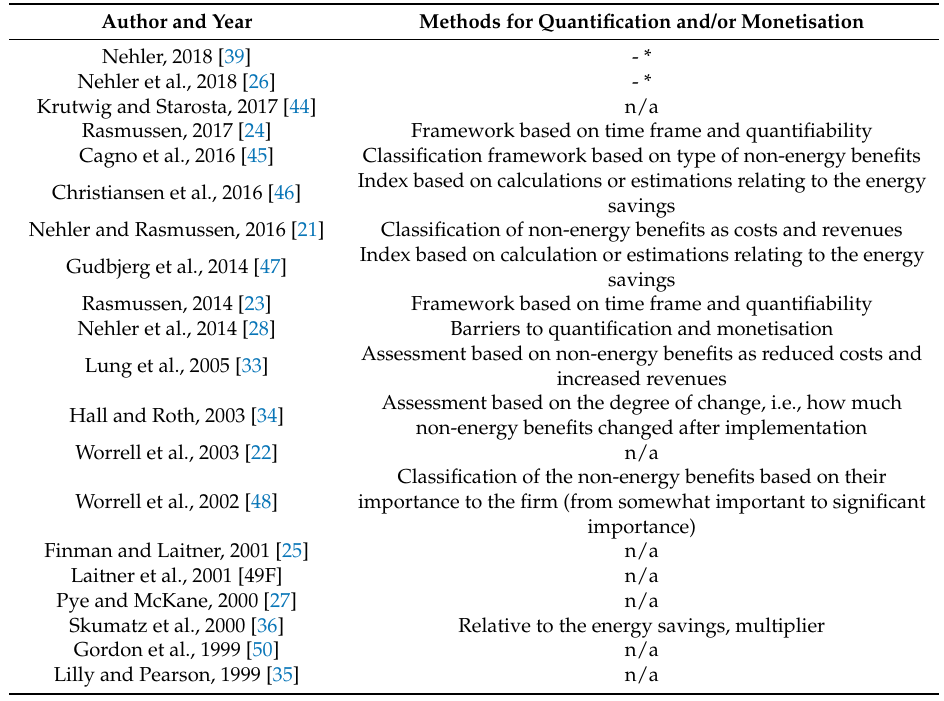
Table 5. Methods applied in the quantification and monetisation of non-energy benefits in the reviewed publications in the area of non-energy benefits in industry. n/a—not